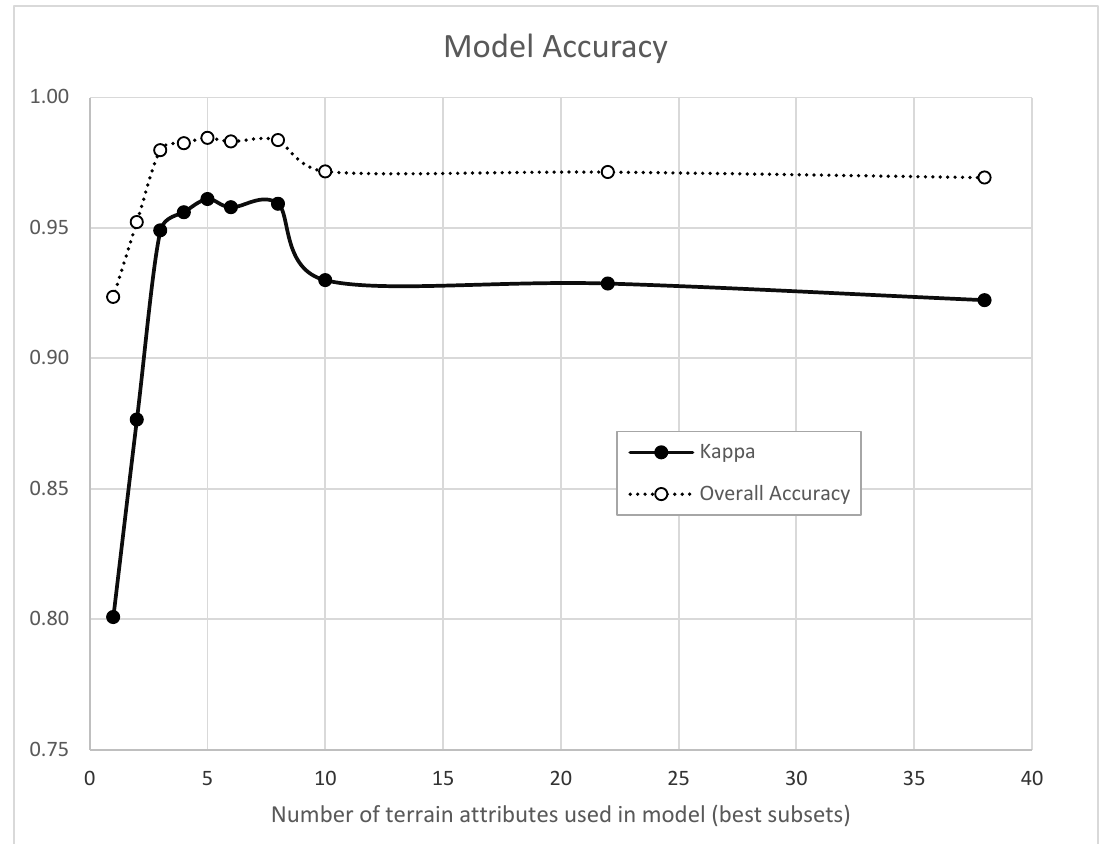
Figure 5. Accuracy of terrace classification using supervised classification random forest algorithm with full model and subsequent subsets after eliminating terms with lowest importance scores.